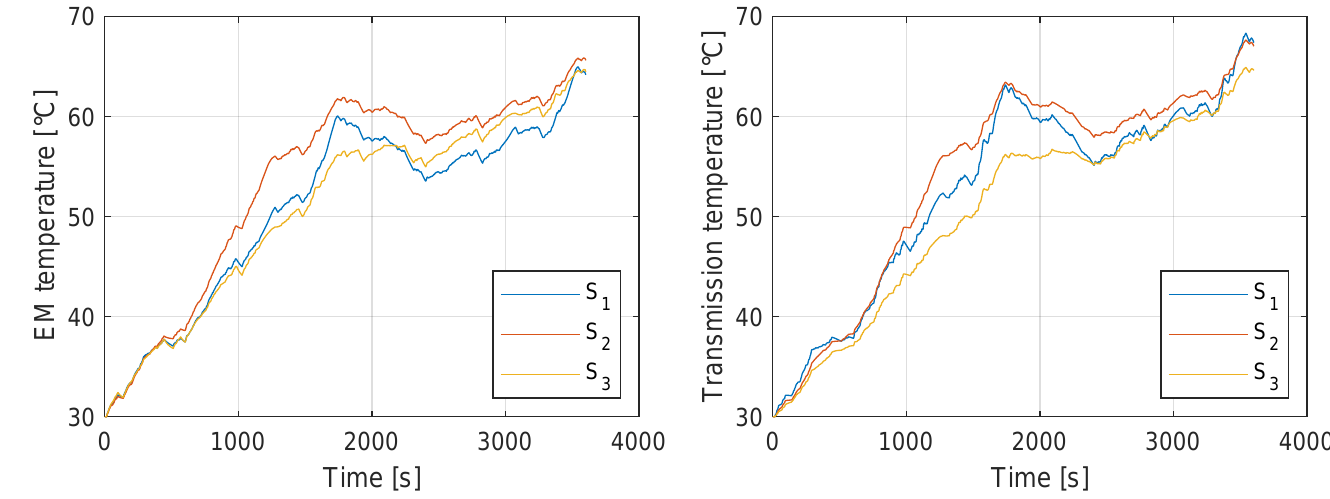
Figure 20. Comparison of temperature profile between S 1 , S 2 and S 3